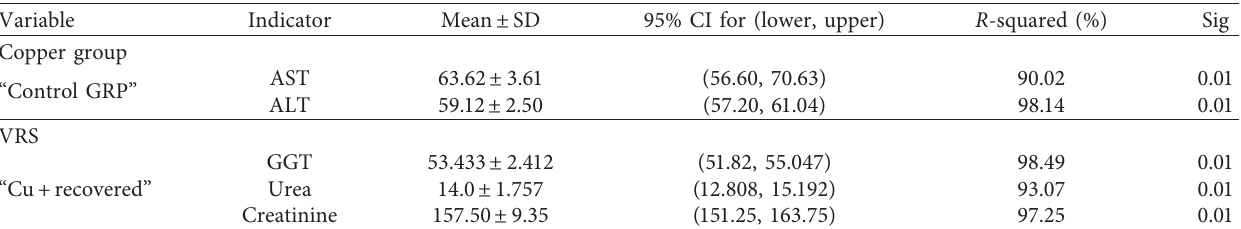
Table 2: Distribution on the effect of copper-induced heavy metal toxicity in rats.